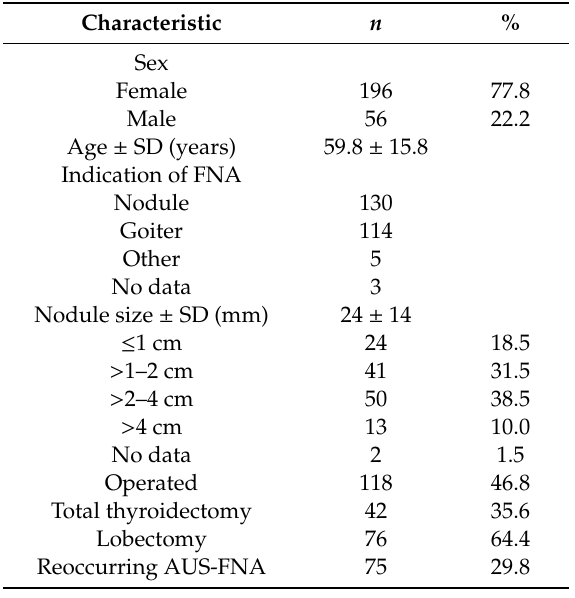
Table 1. Description of the study cohort. FNA, fine-needle aspiration; AUS, atypia of undetermined